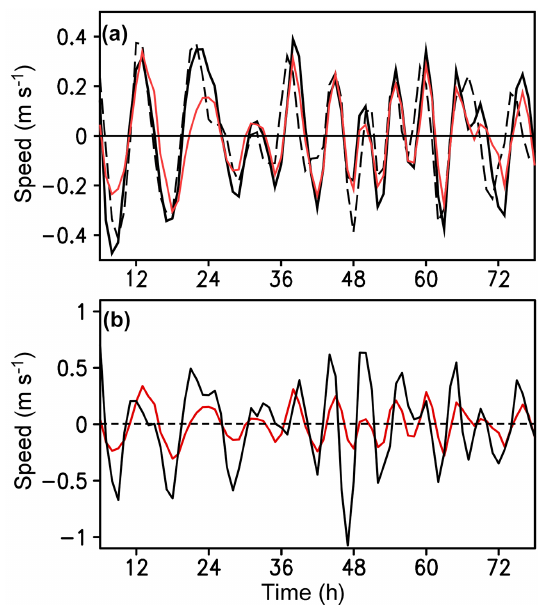
Figure 14. Fluctuations (deviation from the 9h running mean) of (a) the tropical cyclone speed (black solid), the PVT speed (black dashed) and the difference between the tropical cyclone speed and the conventional steering (red solid), and (b) the difference between the tropical cyclone speed and the conventional steering (red solid), and the difference between the contribution of the HA term and the conventional steering